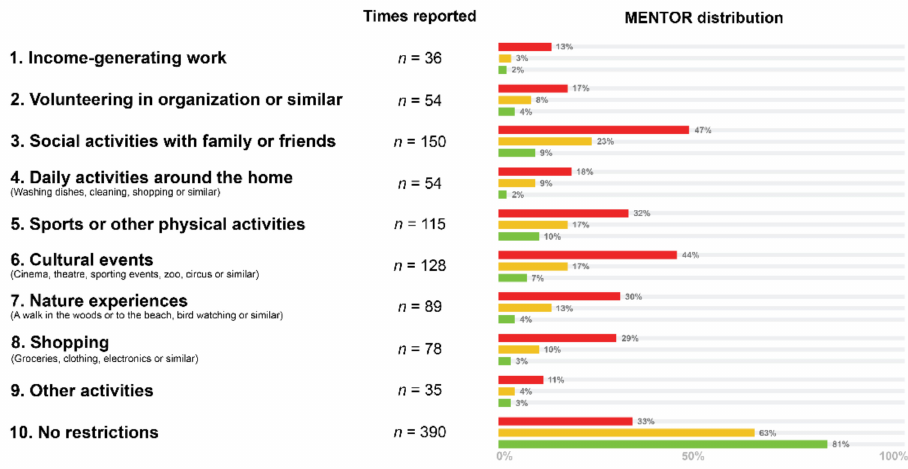
Figure 1. Daily restrictions experienced by the respondents and relative frequency according Monitoring Efficacy of Neurogenic bowel dysfunction Treatment on Response (MENTOR) group. Label: mentor frequencies are derived from the relative count divided by the total number of patients in each of the three MENTOR groups.